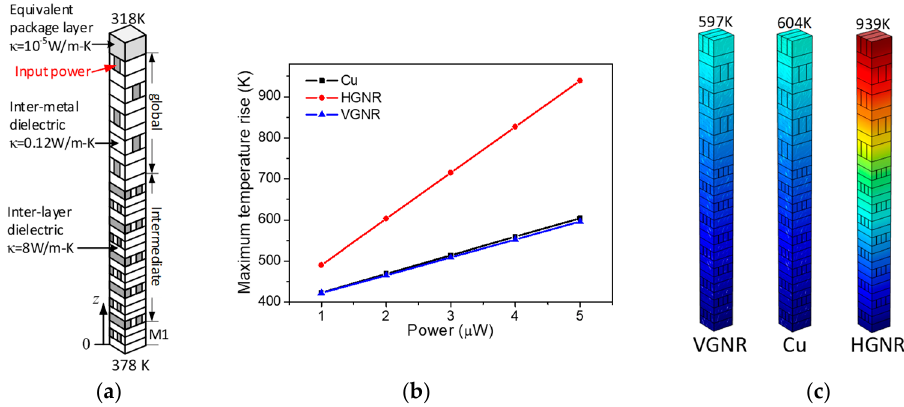
Figure 8. ( a ) Unit cell for simulation. ( b ) Maximum temperature rise on interconnects versus input power. ( c ) Temperature profiles of the unit cell with a power of 5 µW input at the topmost global interconnect [44].